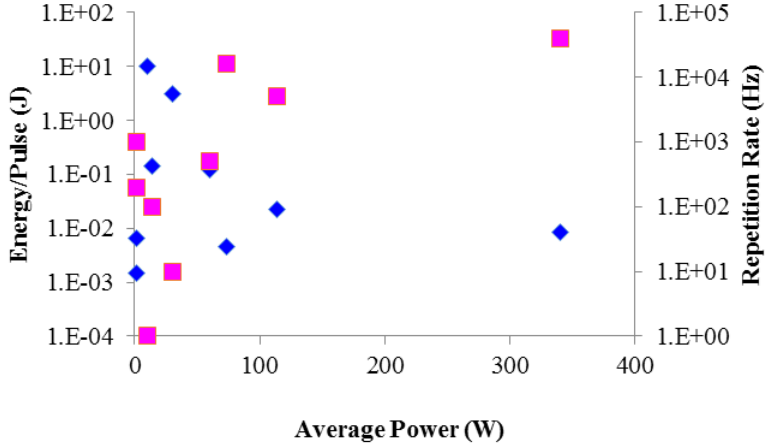
Figure 46. Nanosecond output energy/pulse (blue) and repetition rate (pink) as a function of average power at 1029 nm from demonstrated Yb:YAG cryogenic lasers in the years 2005–2014. Table 9. Reported Cryogenic Q-Switched Yb:YAG Demonstrations From 2005–2011.